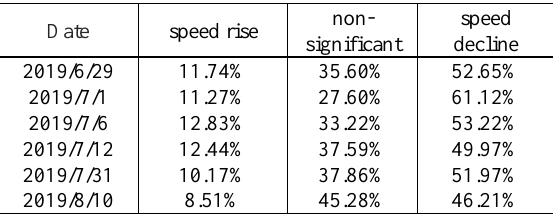
Table 3 . SVR calculation results